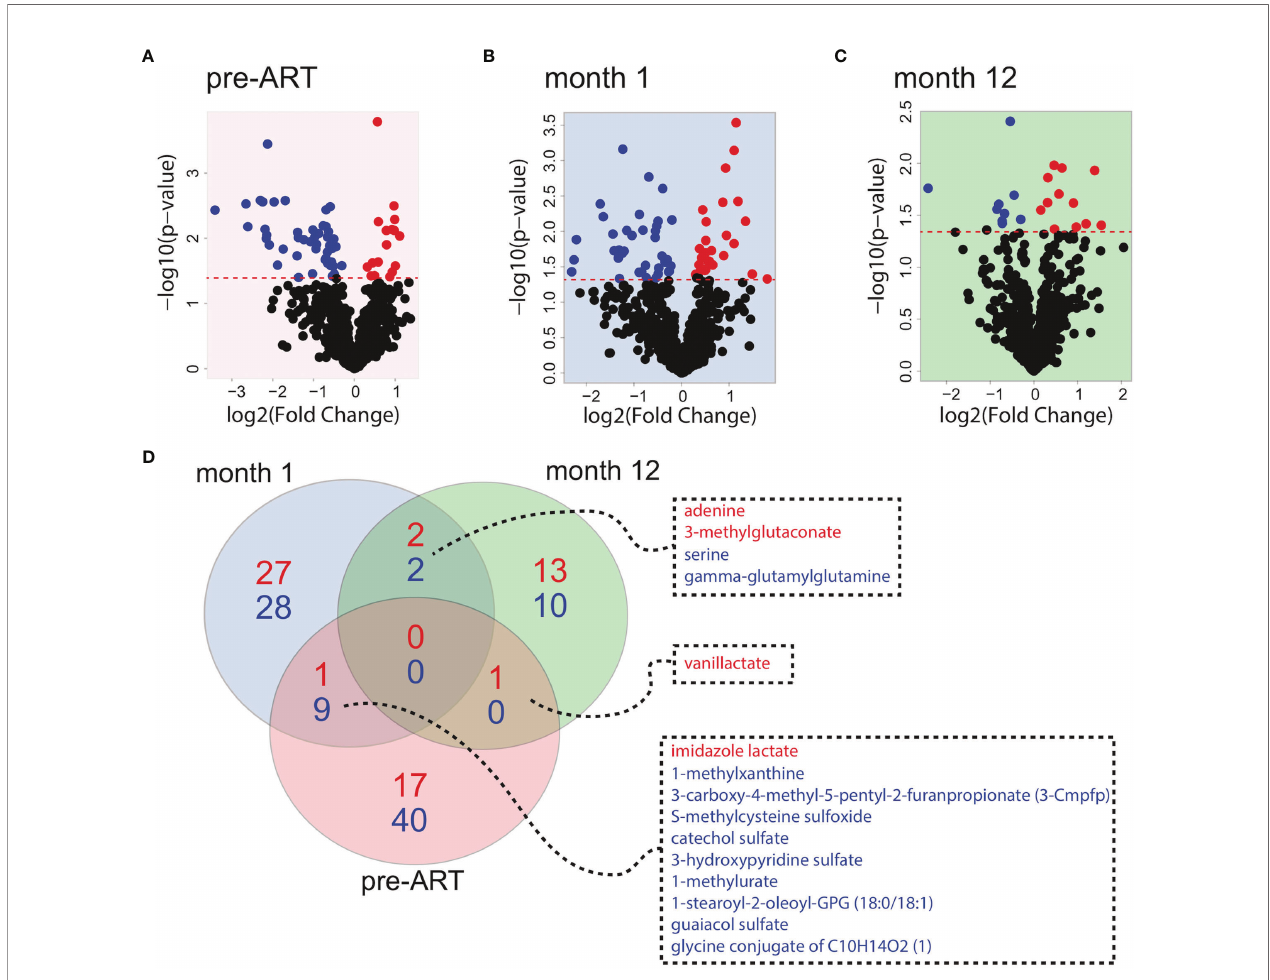
FIGURE 1 | Global metabolite expression comparing IRIS with non-IRIS patients. Volcano plots depicting differences in metabolite levels between IRIS and non-IRIS patients are shown for the pre-ART (A) , month 1 (B) , and month 12 (C) post-ART time points. The signi fi cance threshold ( p -value=0.05) is indicated by the red dashed line. Metabolites above the signi fi cance threshold are de fi ned as the differentially expressed metabolites (DEMs). Each point represents an identi fi ed metabolite that is signi fi cantly upregulated (red) or downregulated (blue) in the IRIS group. (D) Venn diagram illustrating the numbers of differentially expressed metabolites is shown. Blue color represents the number of signi fi cantly downregulated metabolites comparing IRIS and non-IRIS groups, and red color represents the number of metabolites that are